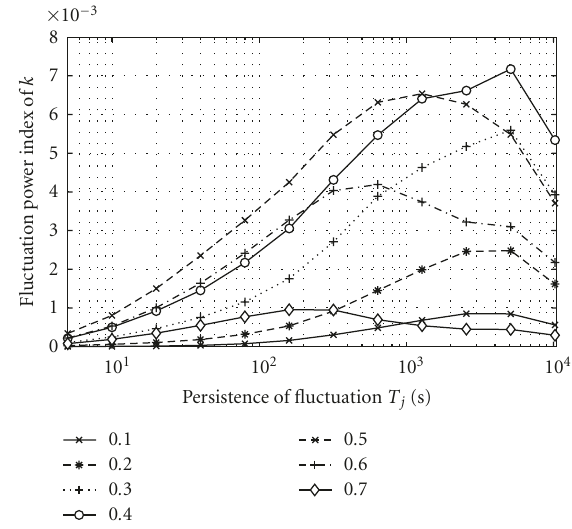
Figure 3: Fluctuation power index c f p of clearness index as a func- tion of persistence T j = S j Δ T , annual mean values; legend: class of daily mean clearness index k